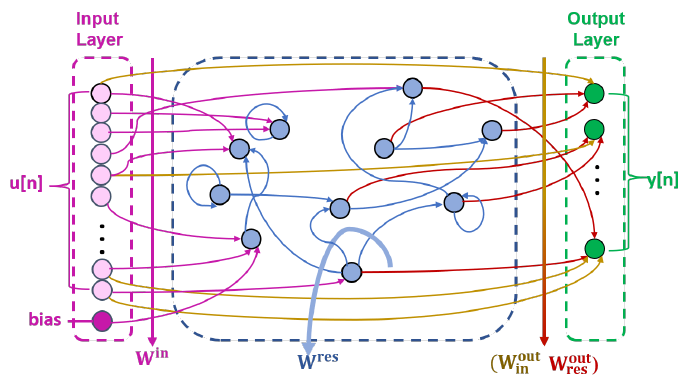
Figure 10. Reservoir computing general